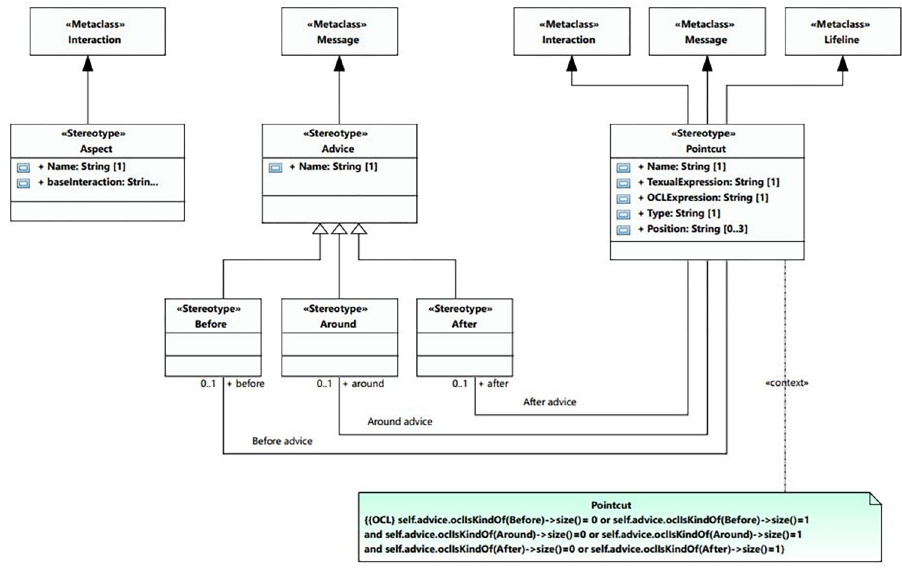
Fig 5. AOM profile